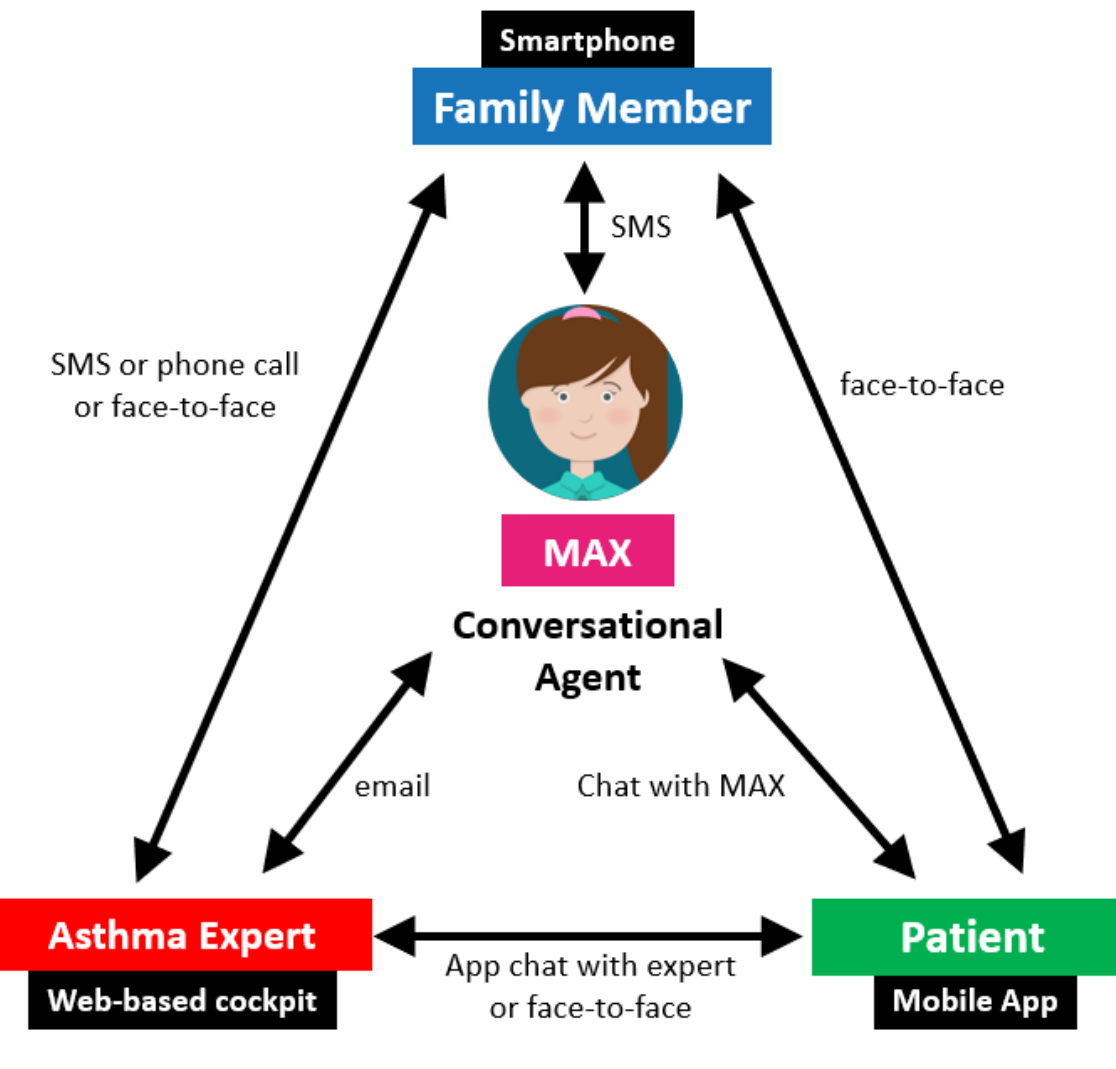
Figure 2. Communication concept of social actors; MAX combines different communication channels and incorporates family members, patients, and asthma experts into on-site and remote counseling